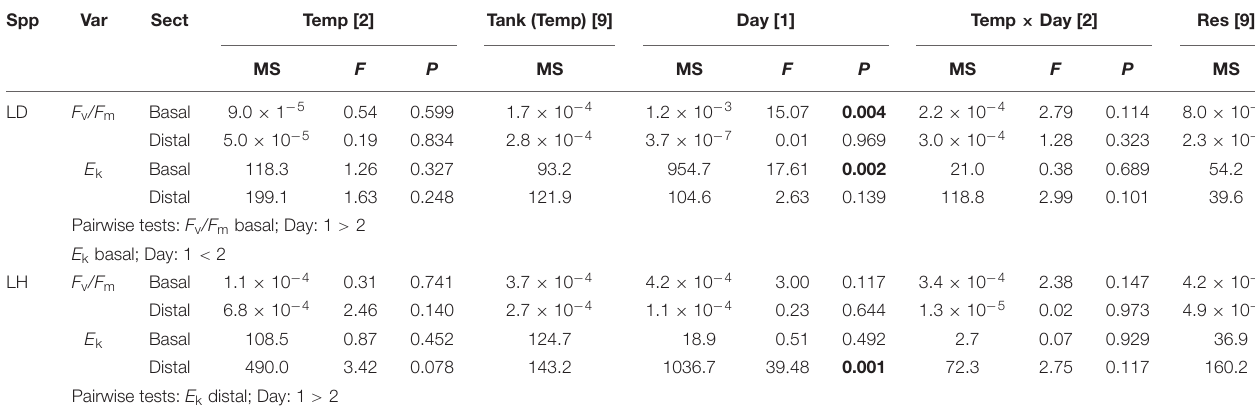
FIGURE 2 | Photosynthetic efficiency ( F v / F m ) of L. digitata (A,C) and L. hyperborea (B,D) at the distal and basal sections of blade tissue under each temperature treatment on days 1 and 2 of the simulated heat spike event, as measured via PAM fluorometry. Data presented as mean ± SE ( n = 4 individual aquaria per treatment). TABLE 2 | The effect of temperature treatment, tank and experimental day on F v / F m and E k , as determined by RM ANOVA for Laminaria digitata and Laminaria hyperborea for both basal and distal blade